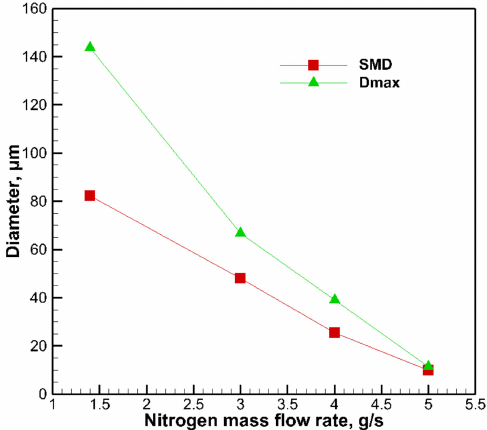
Figure 9. Droplet diameter vs. gas mass flow